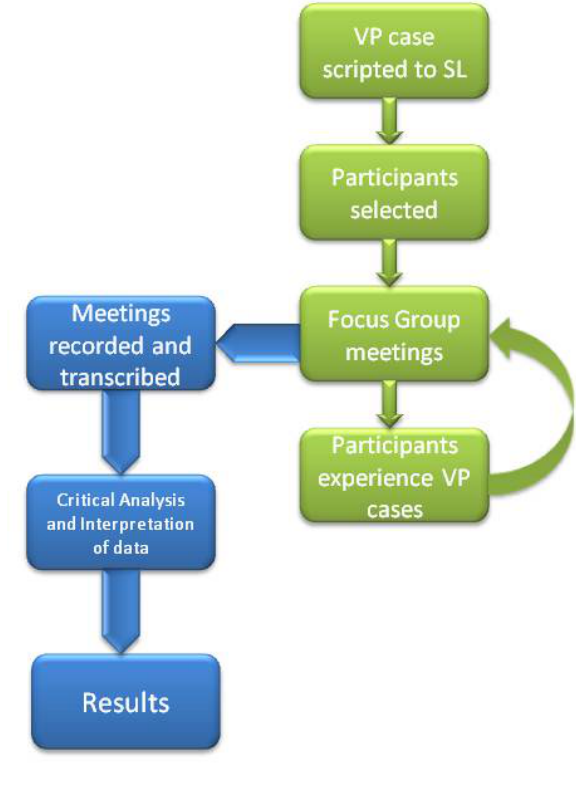
Figure 1. Flow diagram demonstrating this study’s overall methodology. The green area demonstrates the collection of data and the blue area demonstrates analyzing and extracting meaningful results from these data. VP: virtual patient; SL: Second